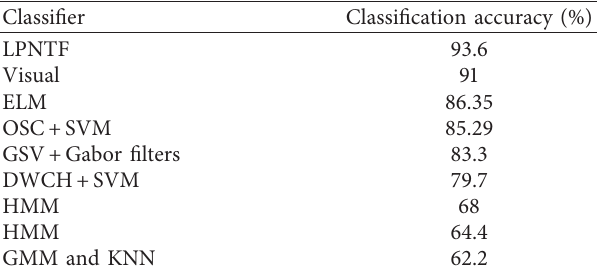
Table 4: Comparison of accuracy of different automatic classifi- cation